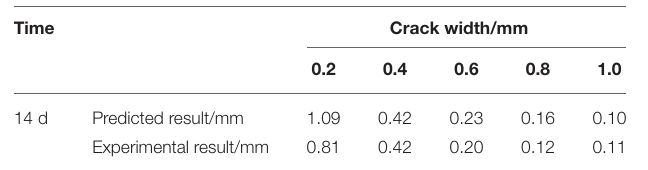
TABLE 5 | The predicted and experimental result of CaCO 3 precipitated depth under different crack